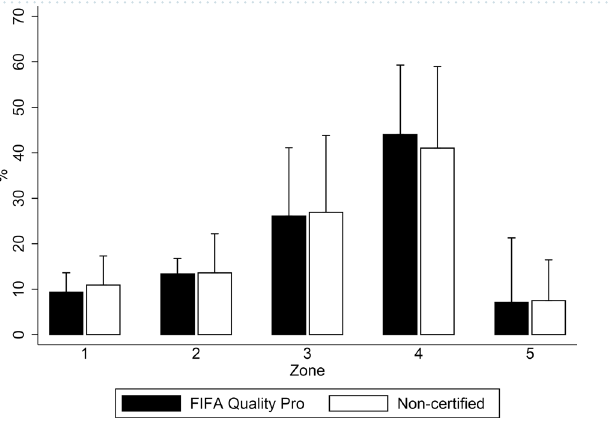
Figure 1. Activity profile during the BEAST 90 in a FIFA Quality Pro and a non-certified artificial turf football field expressed as the total distance covered in different locomotor categories: Zone 1 (0–2 km h −1 ); Zone 2 (2–7 km h −1 ); Zone 3 (7–13 km h −1 ); Zone 4 (13–18 km h −1 ); Zone 5 (18–21 km h −1 ); and Zone 6 (> 21 km h −1 ). *Significant differences between FIFA Quality Pro and non-certified fields ( p < 0.05).